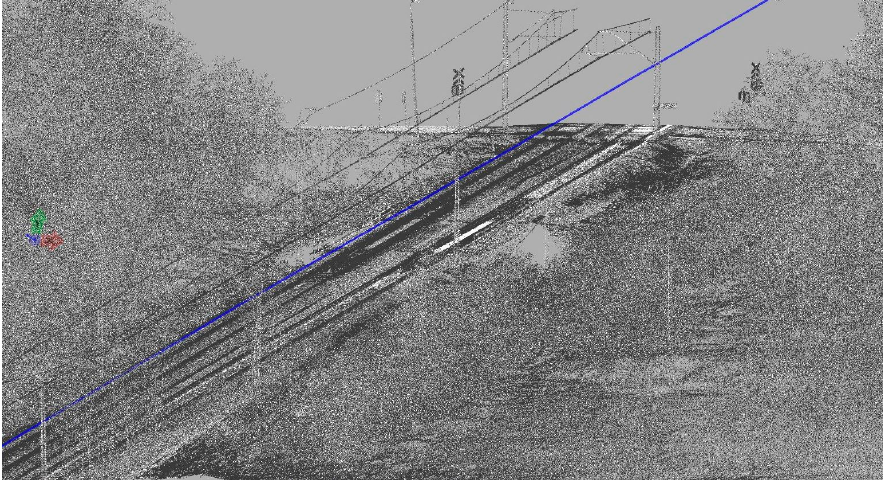
Figure 1. Point cloud collected by a mobile mapping system (MMS) on a rail. Points colored according to intensity; MMS trajectory in blue.